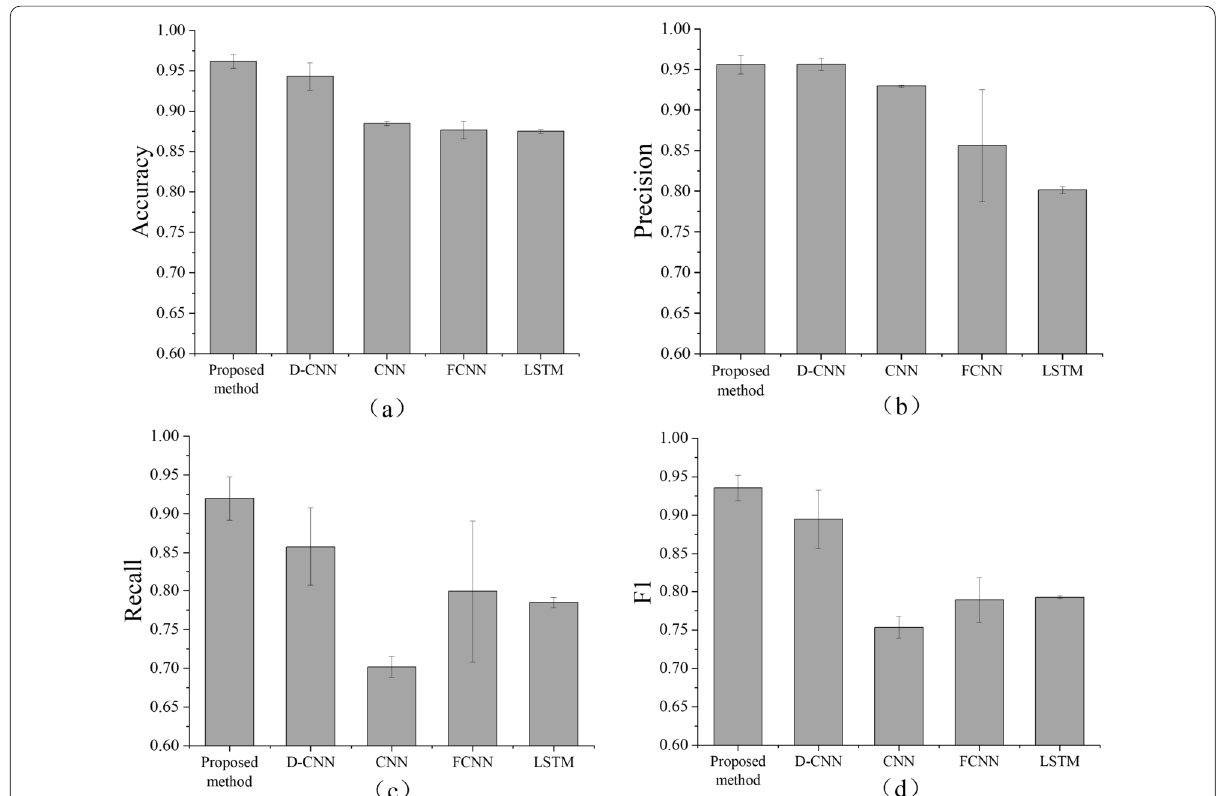
Figure 6 Comparison diagram of four indicators under different